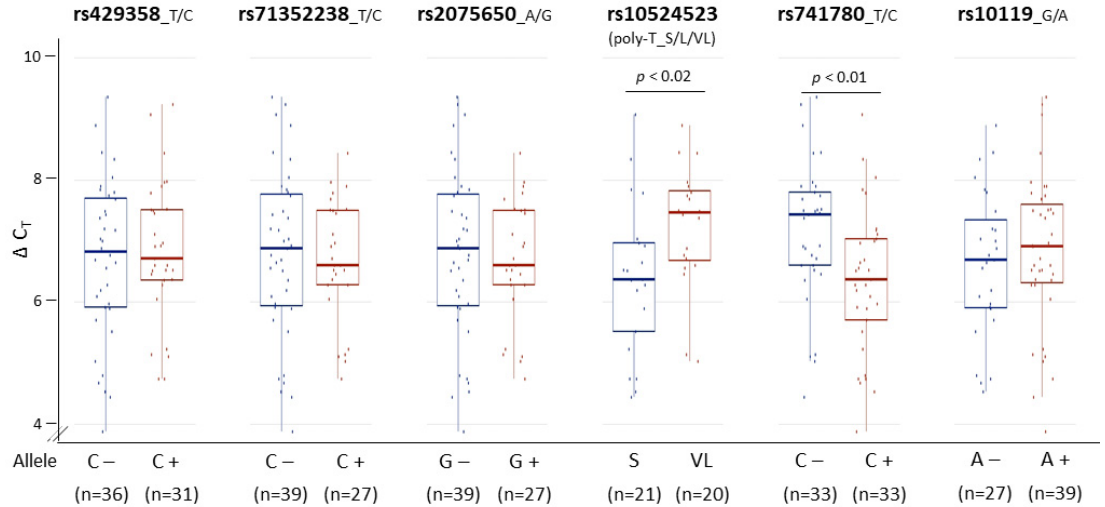
Figure 5. Associations of PMB TOMM40 RNA levels with genetic variants. Transcription levels of PMB TOMM40 RNA were measured by the IVS9 assay and compared across six genetic variants. The t -test p values are shown where significant associations with TOMM40 intron 6 poly-T SNP rs10524523 ( p < 0.02) and intron 8 SNP rs741780 ( p < 0.01) were detected. For rs10524523, the S group includes S/S homozygotes and S/L heterozygotes, and the VL group includes VL/VL homozygotes and VL/L heterozygotes. Numbers in parentheses denote sample size. Boxplot shows quartiles and median.